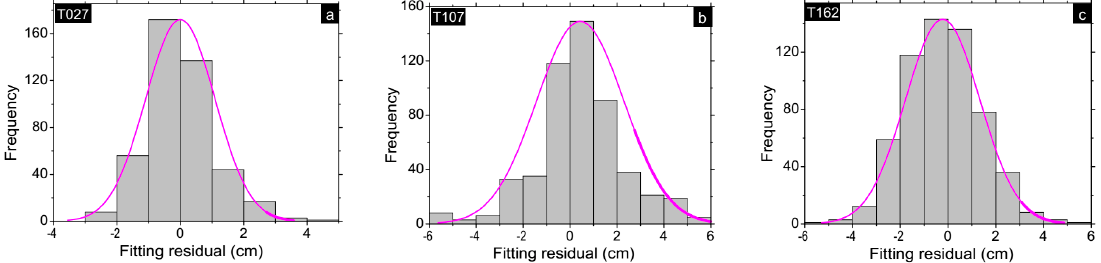
Figure 8. Histogram of residuals (Figure 4c,f,i) between the observed (Figure 4a,d,g) and model-predicted (Figure 4b,e,h) coseismic displacements for the ascending Sentinel-1A track T027A ( a ), the descending Sentinel-1B track T107D ( b ) and the ascending ALOS-2 track T162A ( c ), respectively.